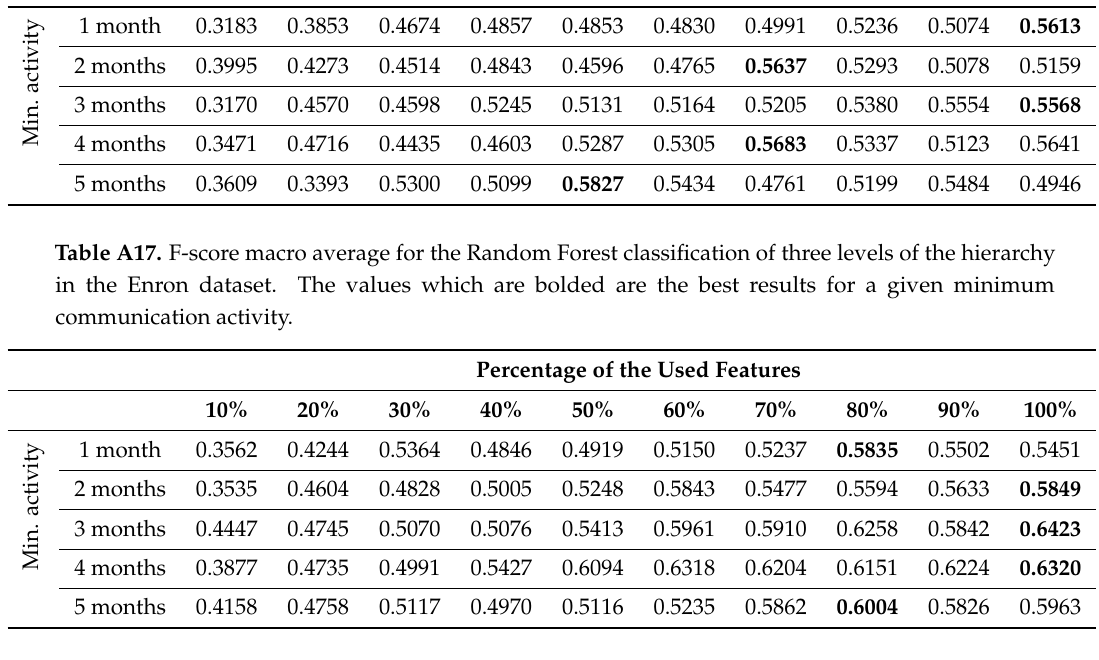
Table A18. F-score macro average for the Neural Network classification of three levels of the hierarchy in the Enron dataset. The values which are bolded are the best results for a given minimum communication activity.